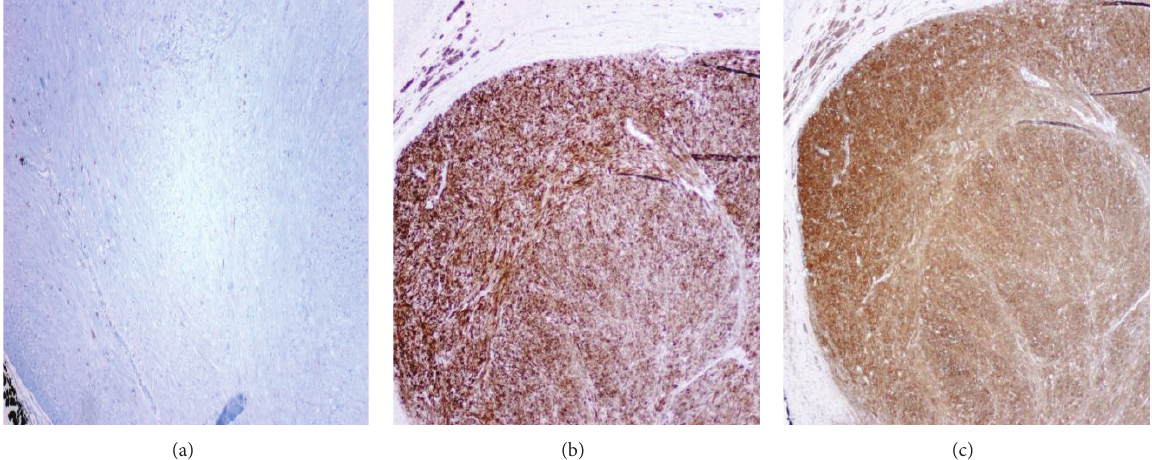
Figure 6: (a) ELM negative for CD117 (C-Kit). (b, c) LM diffusely and strongly positive for desmin and SMA stain,